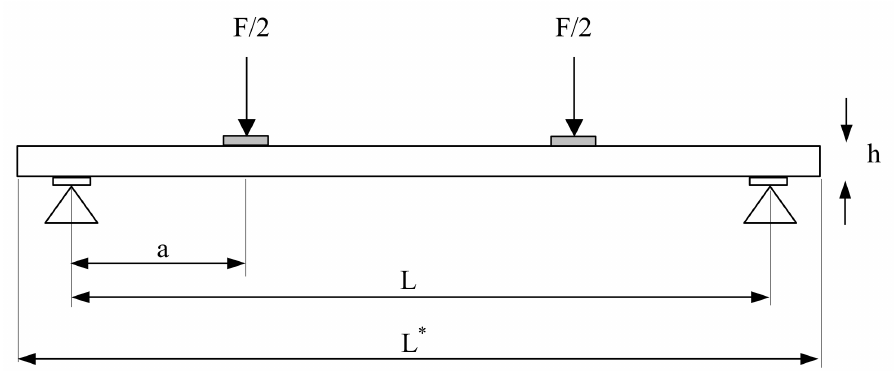
Figure 1. Example of load determination.